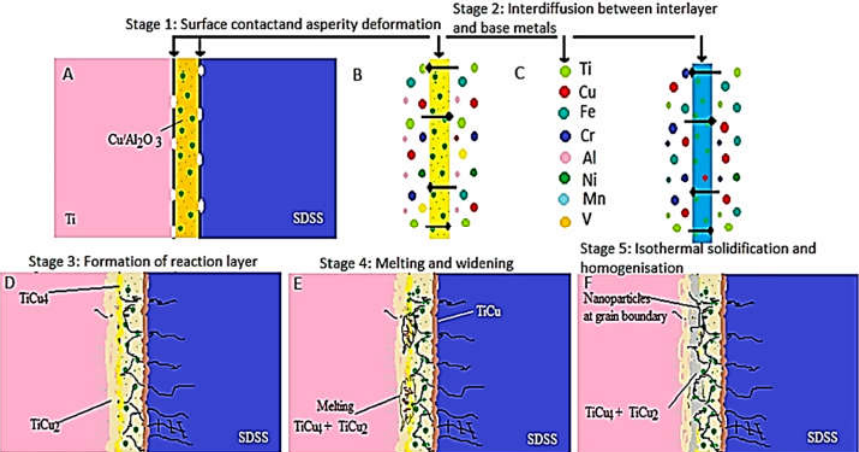
Figure 11. A schematic of the mechanism involved in the bond formation of Ti–6Al–4V and super-duplex stainless steel using a Cu/Al 2 O 3 interlayer: ( A ) initial surface contact and asperity deformation; ( B, C ) interdiffusion between interlayers and base metals; ( D ) formation of the reaction layers; ( E ) eutectic melting which occurs in samples bonded at 900 °C; ( F ) isothermal solidification and homogenization of the interface [68].